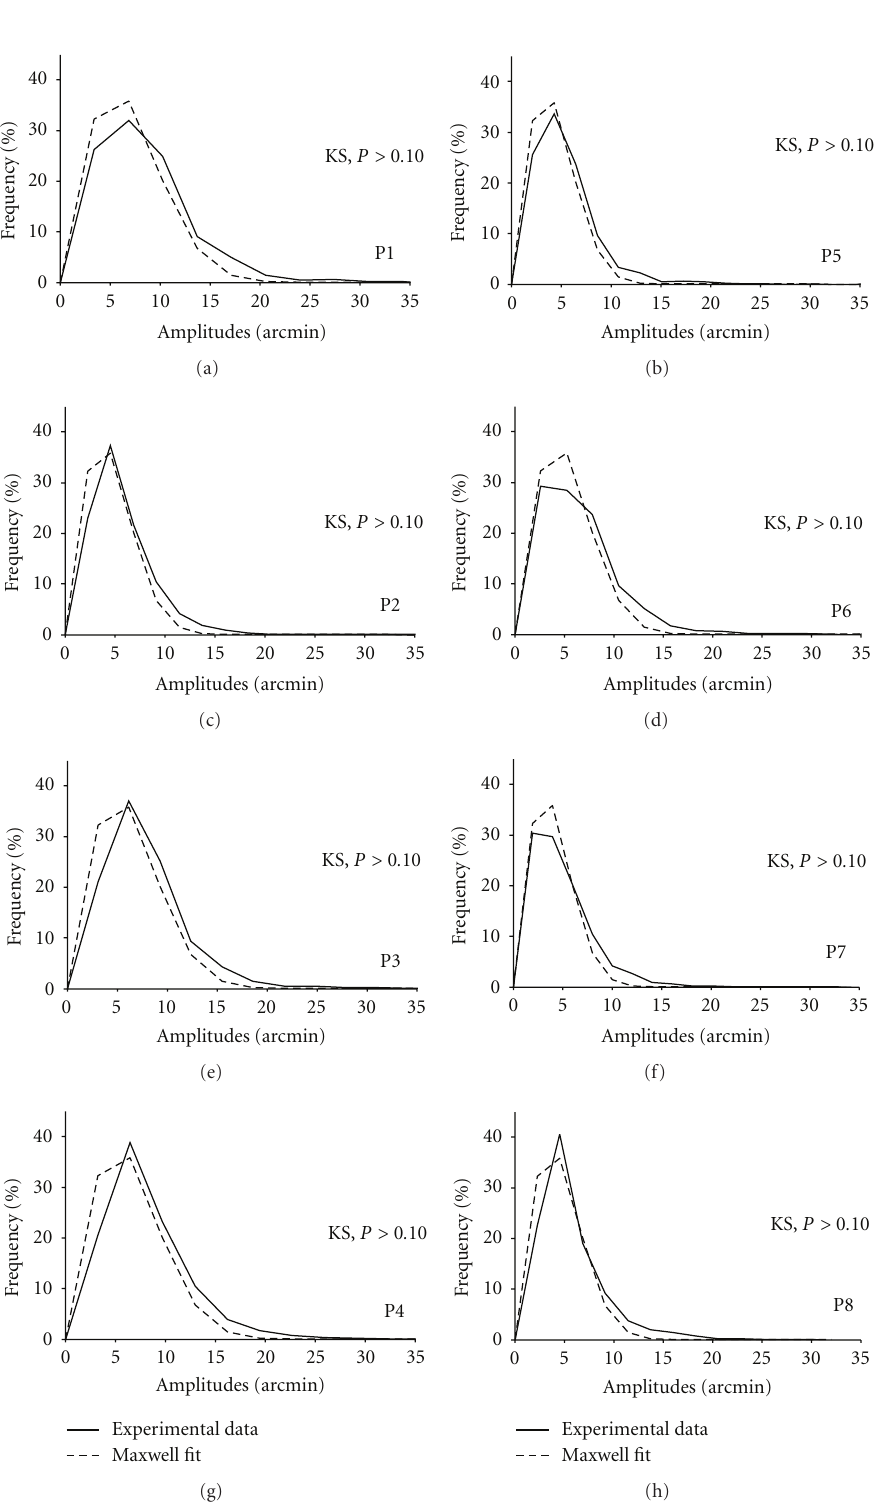
Figure 3: Probability density function (PDF) of eye-movement amplitudes for each participant (P1 to P8). For each graph, we show the frequency (in percentage points) as a function of amplitudes (in arcmin). The experimental PDF is shown in the full line, and Maxwell’s theoretical PDF in the dotted line. For each participant, data of the 16 scenes were pooled together. Bin width was optimized using Nash and Sutcli ff e’s criterion and set to m/ 2 arcmin, where m is the mean amplitude of eye movements. KS: Kolmogorov-Smirnov (KS) two-sample test between experimental and theoretical